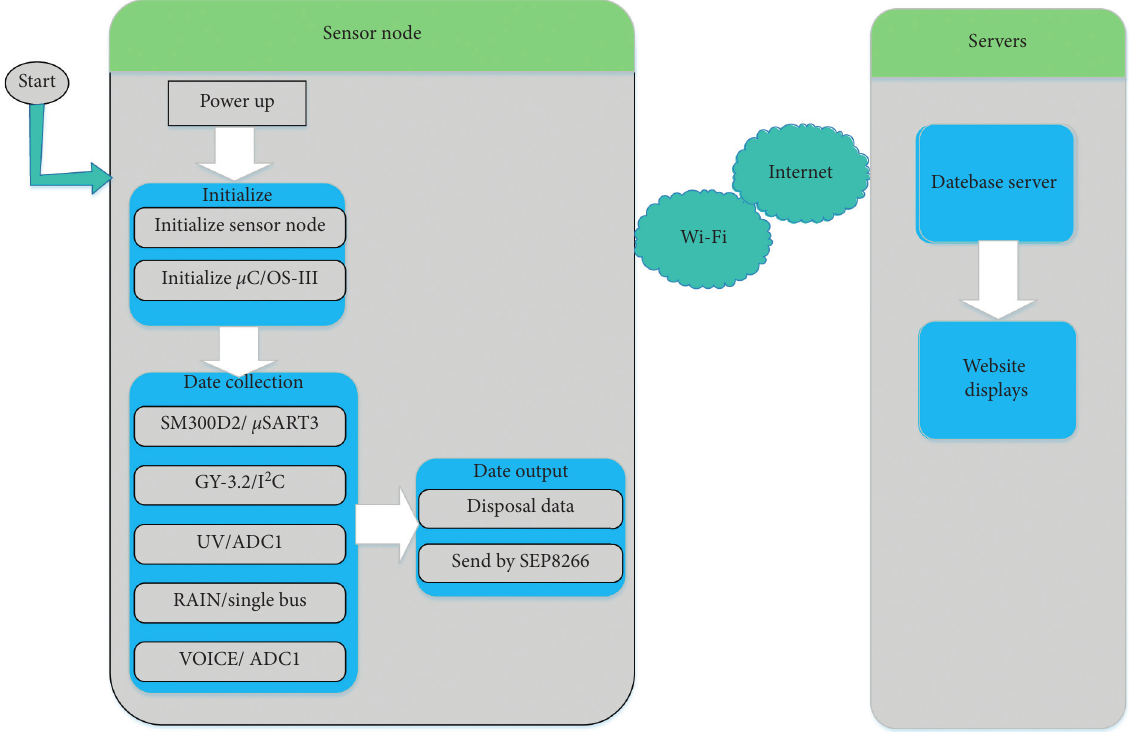
Figure 5: Software flowchart of the